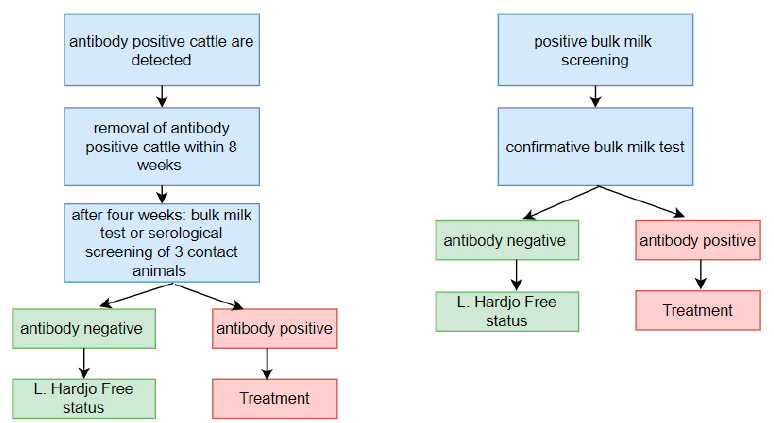
Figure 1. Control actions following detection of antibody positive cattle or bulk milk screening in the Leptospira Hardjo Control Programme .